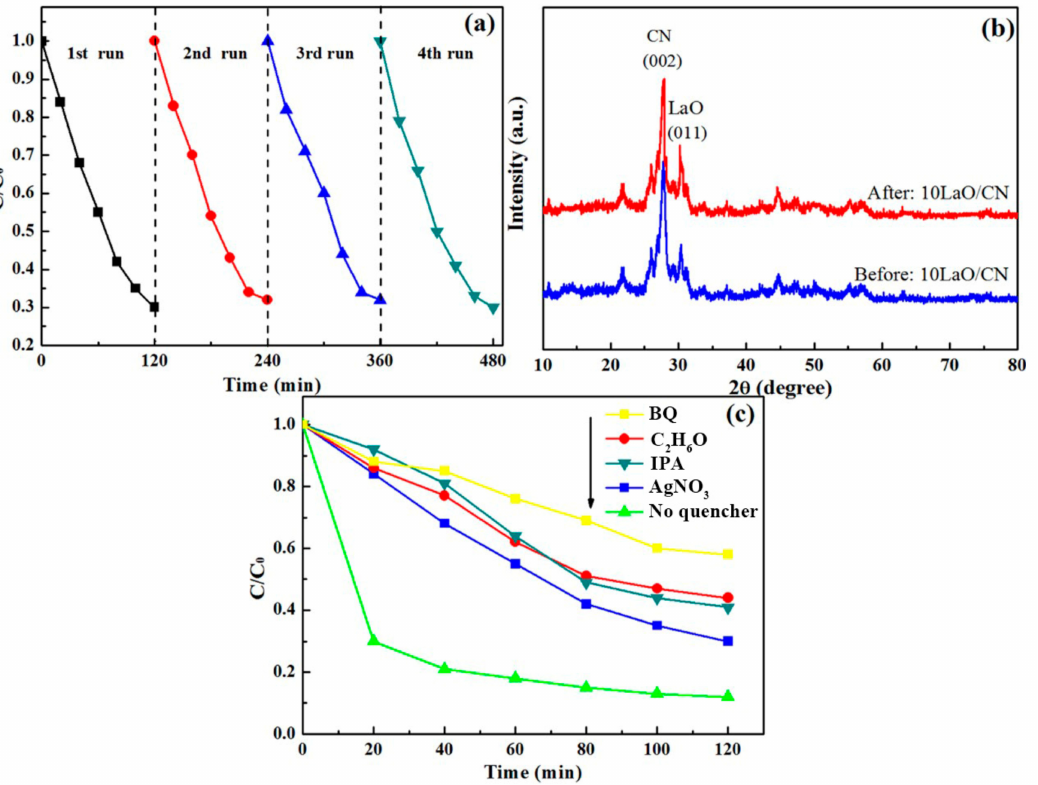
Figure 9. Reusability of photocatalytic activities experiment on 10LaO/CN photocatalysts ( a ); XRD patterns of 10LaO/CN before and after the degradation of TTCH ( b ); the effect of active species in TTCH degradation ( c